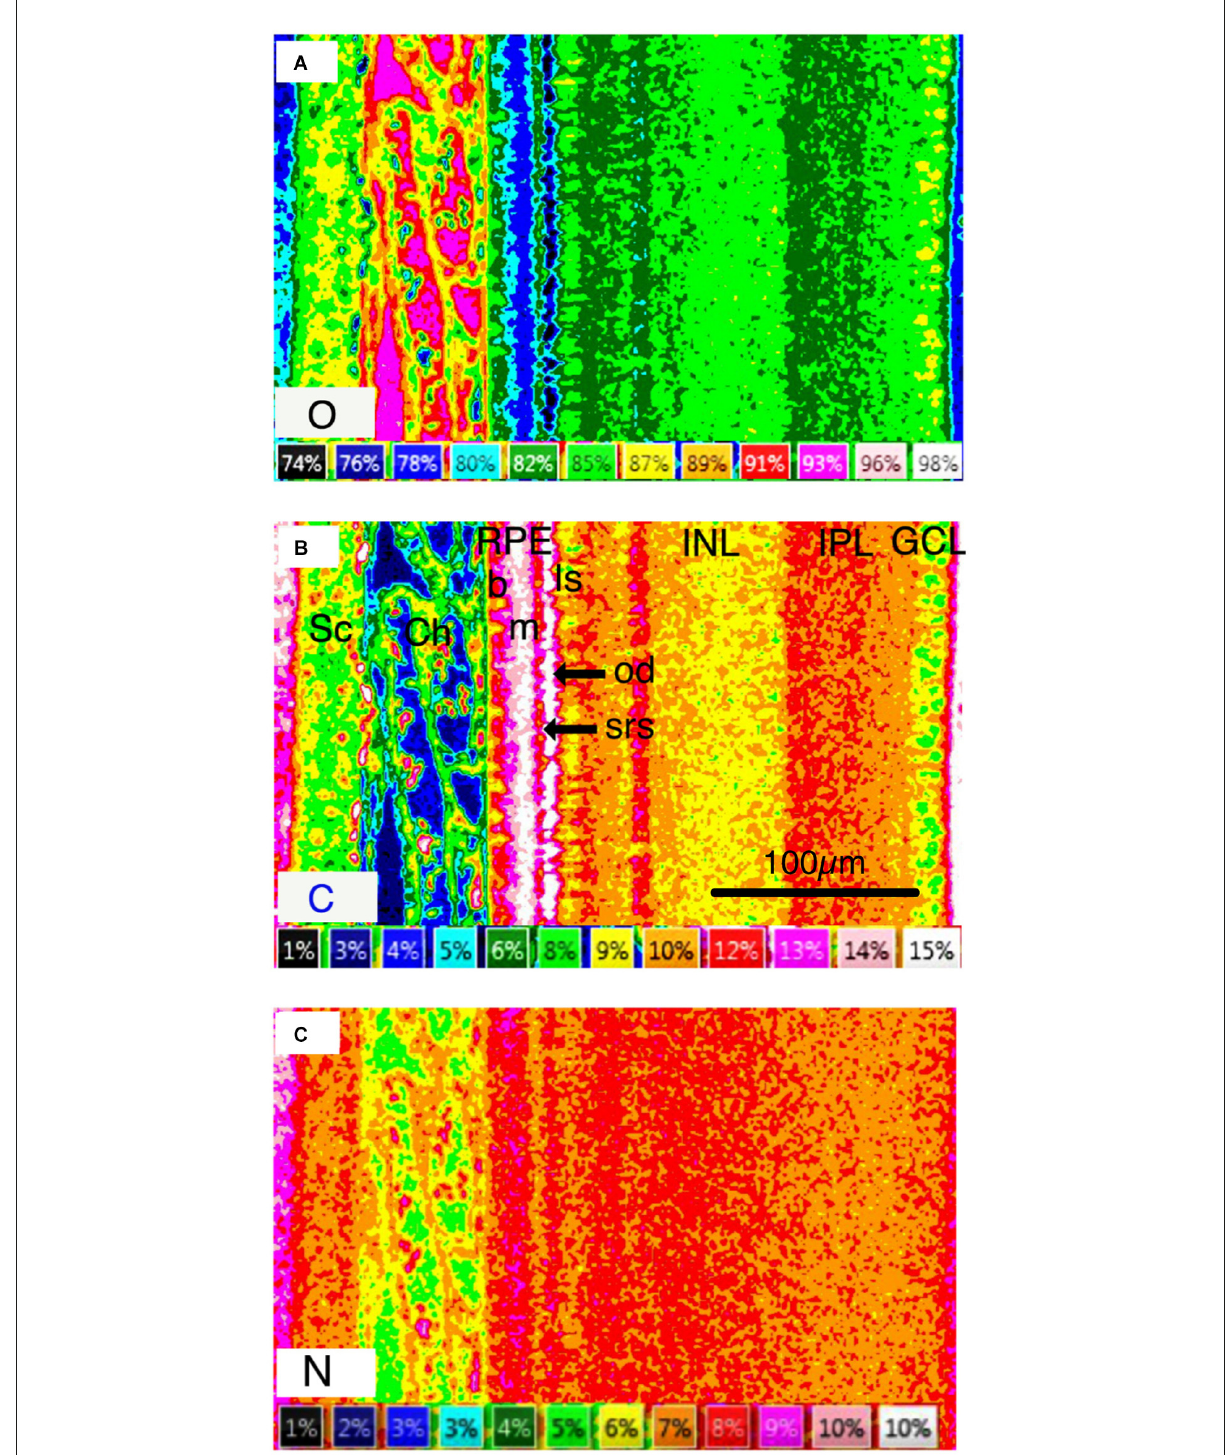
FIGURE4 Quantitative concentration images of frozen-hydrated retinal complex in weight percent. (A) Oxygen [O] concentration is a proxy for water concentration. (B) Carbon [C] concentration image of frozen-hydrated retinal complex in weight percent. Carbon concentration is a proxy for organic mass. (C) Nitrogen [N]. Abbreviations: O, oxygen; C, Carbon; Sc, sclera; Ch, choroid; RPE, retinal pigment epithelium; b, basal region of RPE; m, apical melanosome-containing region of RPE; Is, inner segment of photoreceptor layer; od, oil droplets; SRS, subretinal space; INL, inner nuclear layer; IPL, inner plexiform layer; GCL, ganglion cell layer. (C) Nitrogen [N] concentration